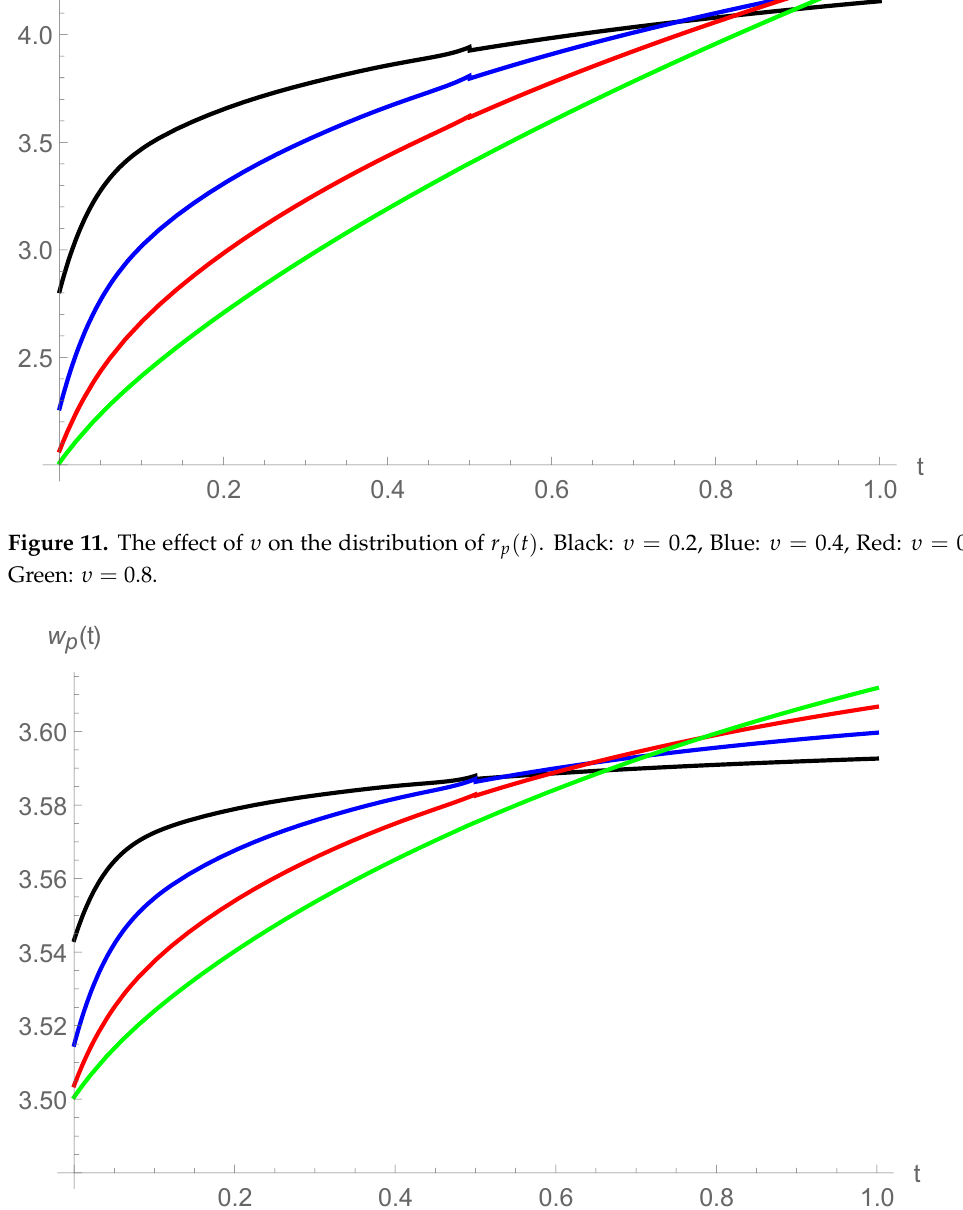
Figure 12. The effect of υ on the distribution of w p ( t ) . Black: υ = 0.2, Blue: υ = 0.4, Red: υ = 0.6, Green: υ =